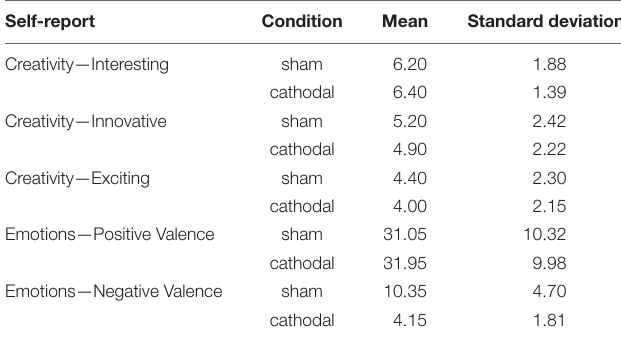
TABLE 1 | Mean scores and standard deviation for self-report evaluation of creativity and emotional